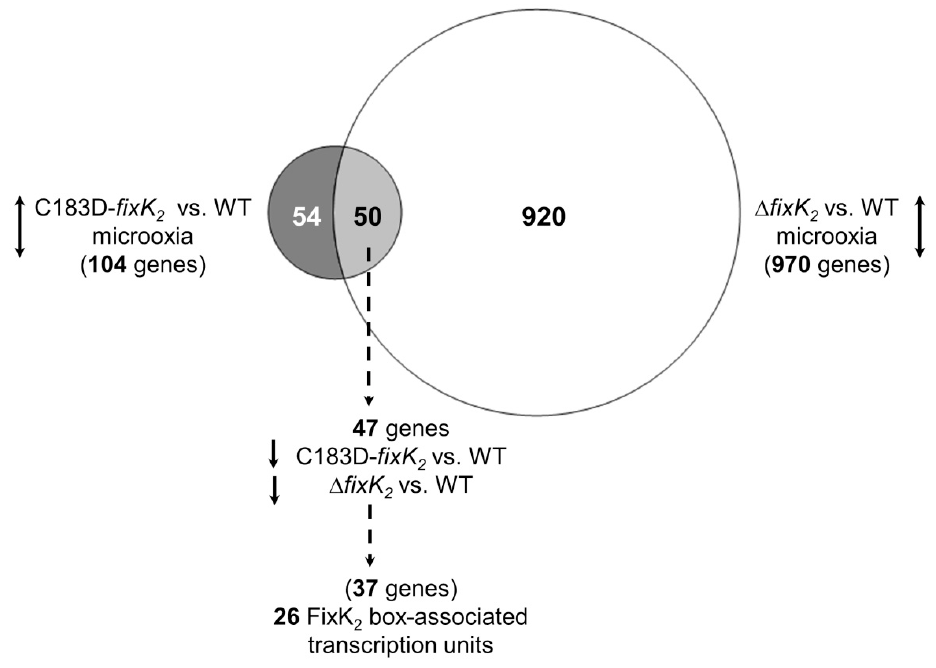
Figure 7. Workflow of microarray data analyses of the C183D- fixK 2 strain. Labels of the comparisons between specific transcription profiles are depicted alongside the circles. The total number of differentially expressed genes is indicated in parentheses. Up/down arrows refer to increased and decreased gene expression. The group of genes with differential expression in the C183D- fixK 2 strain (dark grey circle, left) showed an overlap of 50 genes (light grey circle, middle) with those in Δ fixK 2 strain (white circle, right; [19]), both grown microoxically (0.5% O 2 ) and compared with the wild type grown in the same conditions. Within the overlap, 47 genes showed downregulated expression in both the C183D- fixK 2 and Δ fixK 2 strains, which includes 37 genes organized in mono- or polycistronic transcriptional units that harbor a putative FixK 2 box within the promoter region (26 putative transcriptional units, see Table 2).